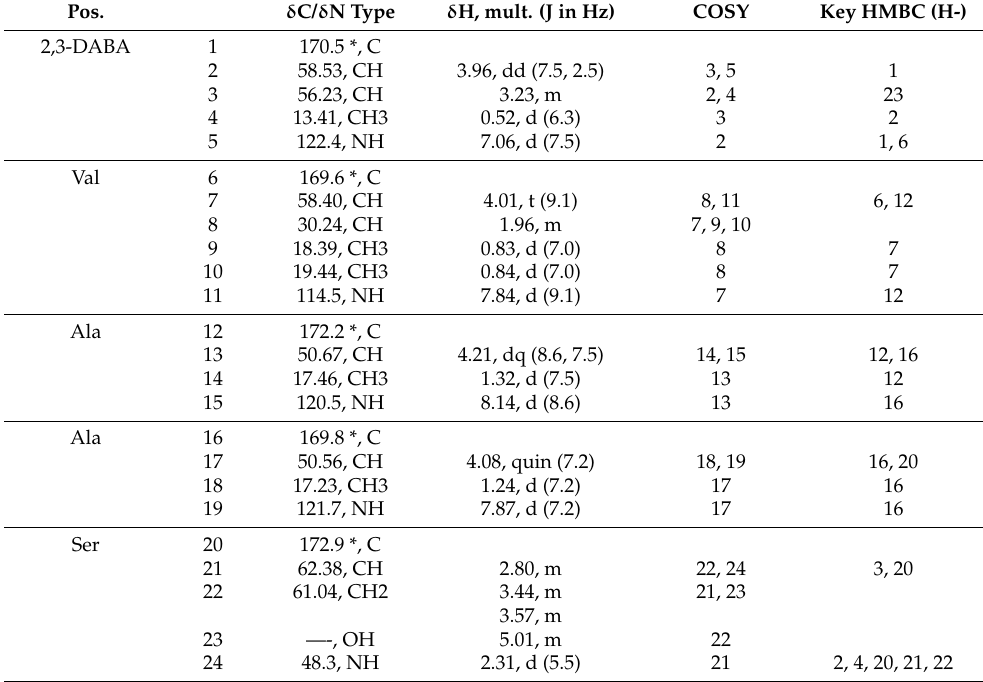
Table 1. NMR data of bonsecamin in DMSO- d 6. Pos. δ C/ δ N Type δ H, mult. (J in Hz) COSY Key HMBC (H-) 2,3-DABA